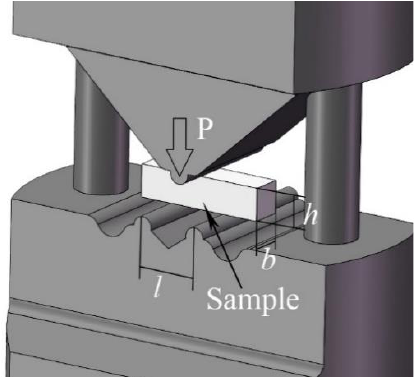
Figure 2. Schematic illustration of the flexural strength test.